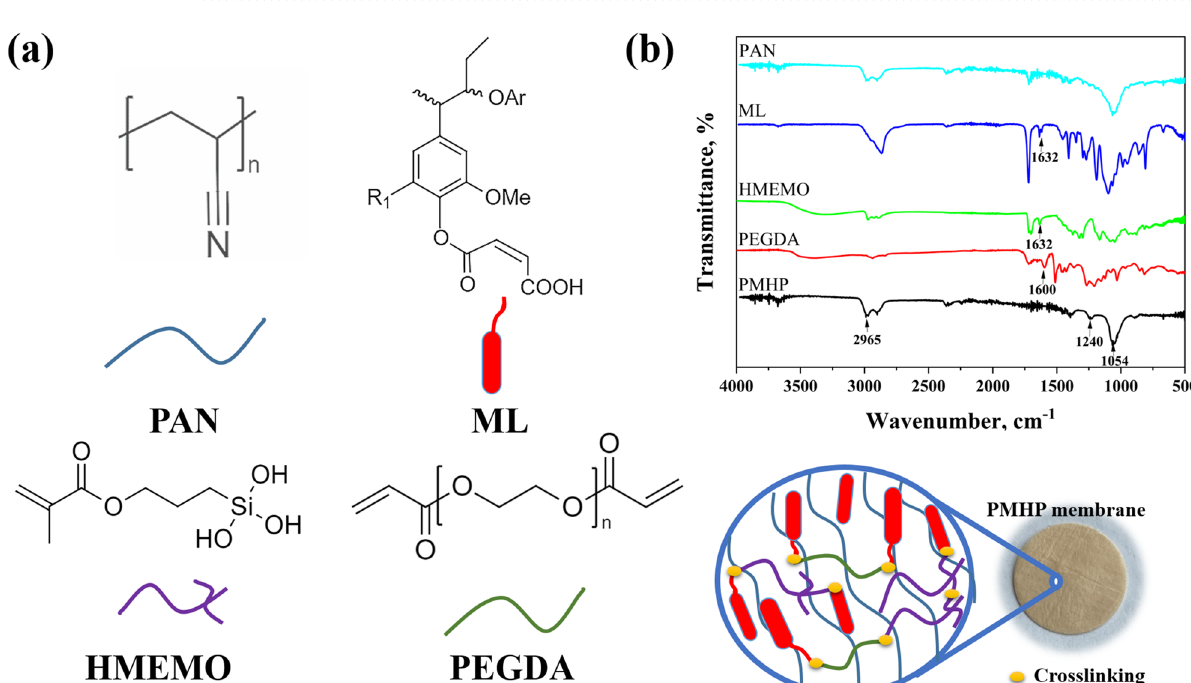
Figure 3. ( a ) Chemical composition, ( b ) FT-IR spectra and photo of PMHP